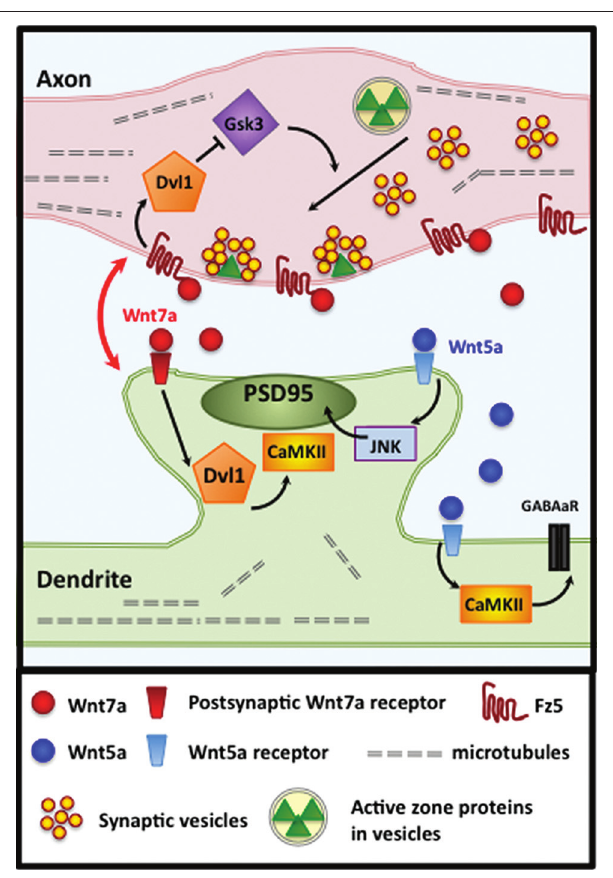
FIGURE 2 | Wnt7a signals bi-directionally at vertebrate synapses. At hippocampal synapses, coordinated bidirectional Wnt7a signaling regulates synapse assembly, development and maintenance. In the axon, Wnt7a binds with Fz5 to activate a divergent-canonical pathway through Dvl1 and Gsk3 β that promotes the recruitment of synaptic components, including SV and active zone proteins. In postsynaptic dendrites, Wnt7a promotes spine morphogenesis, PSD-95 recruitment and synaptic strength by signaling via Dvl1 and CaMKII. The postsynaptic Wnt receptor has yet to be determined. Wnt5a signals postsynaptically to promote PSD95 clustering via JNK activation and GABA A receptor clustering via CaMKII. The postsynaptic Wnt5a receptor has yet to be